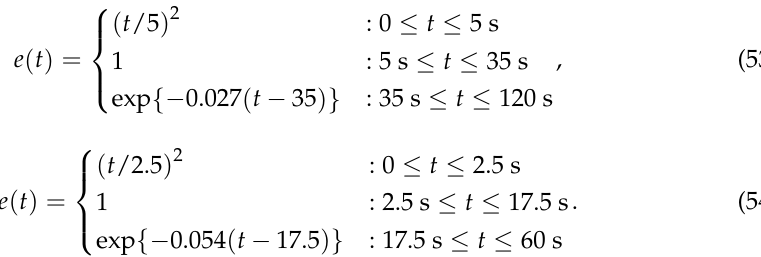
Figure 4 shows the time-histories of the artificial ground accelerations of Art-L-00 and Art-S-00, respectively.